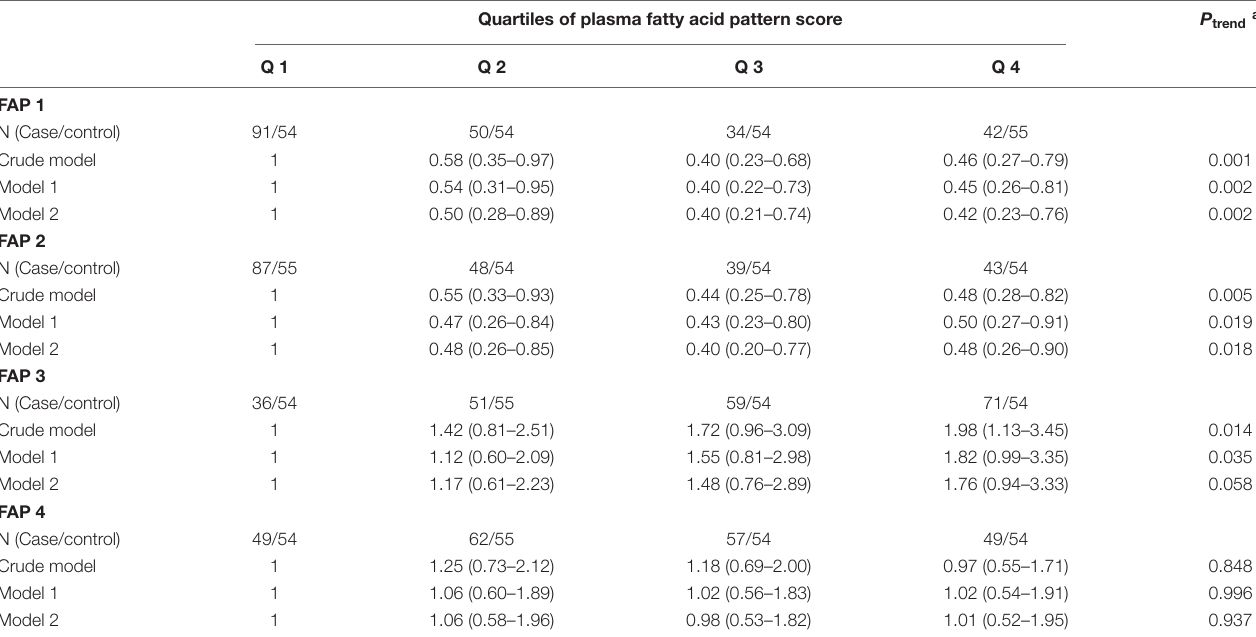
TABLE 6 | ORs (95% CIs) for GDM according to quartiles of plasma fatty acid pattern scores. Quartiles of plasma fatty acid pattern